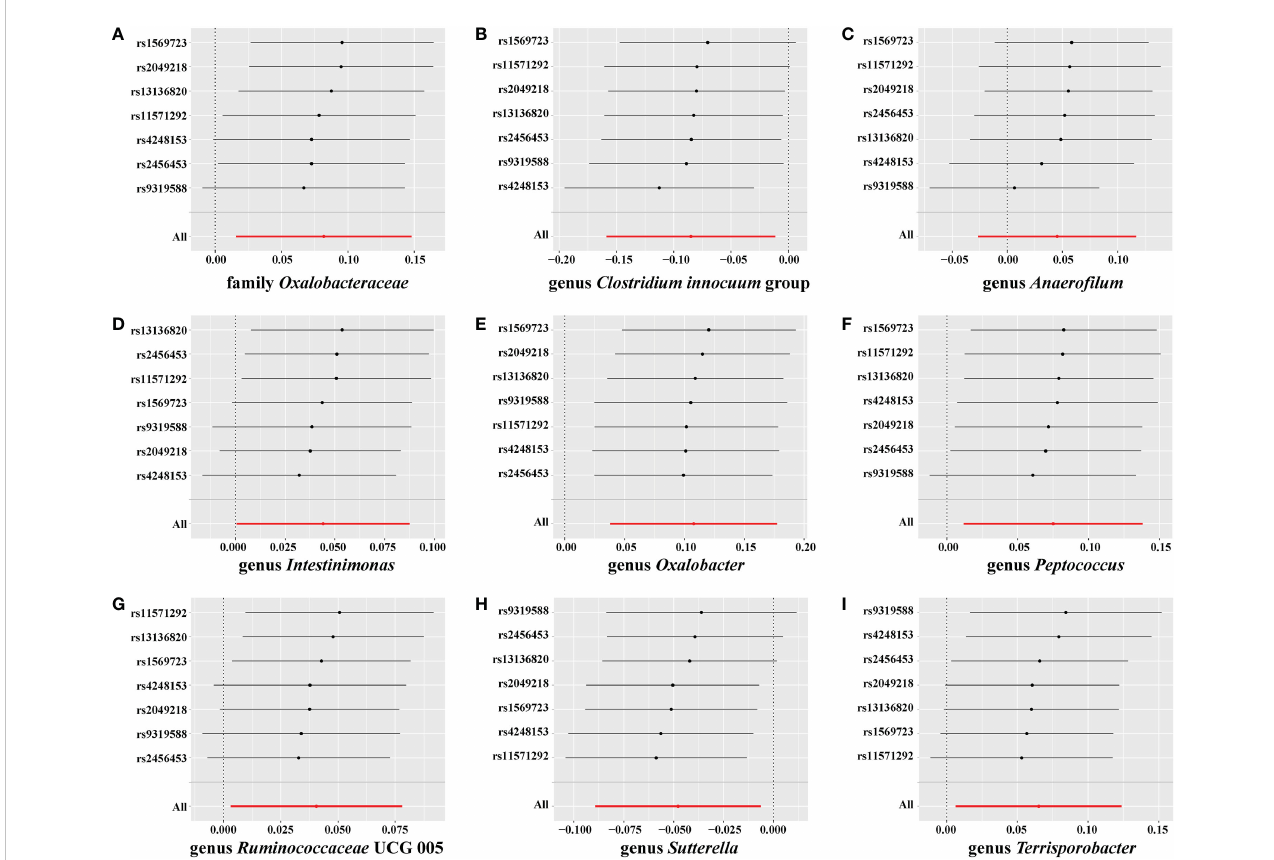
FIGURE 6 Leave-one-out analysis for Graves ’ disease (GD) on the gut microbiome. The sensitivity of the causal effect of GD on a different type of gut microbiome was analyzed using leave-one-out analysis in (A – I) . The error bar represents the 95% con fi dence interval with the method of inverse-variance weighting